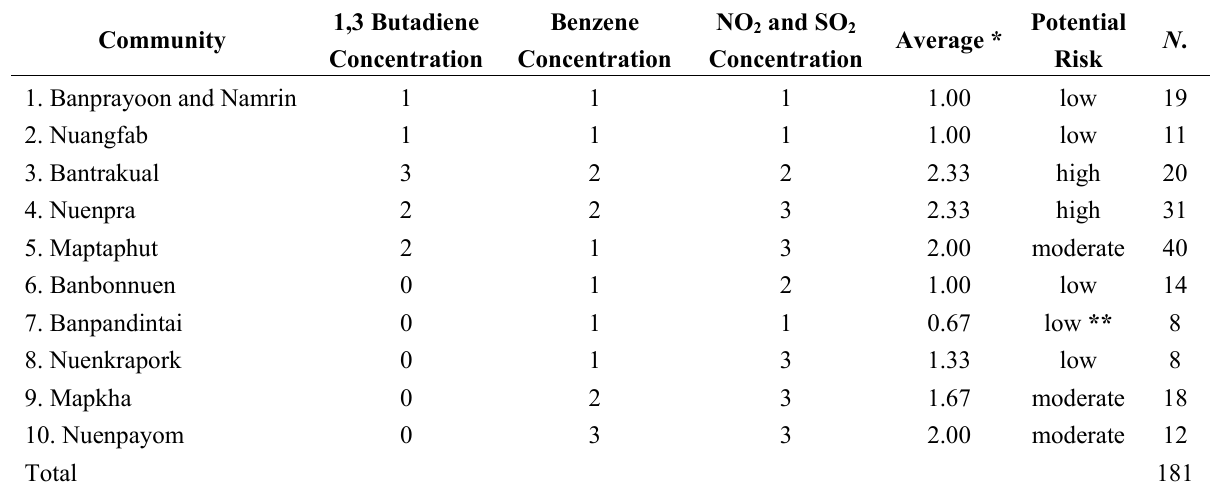
and SO Potential NO 2 2 Average * N Concentration Risk